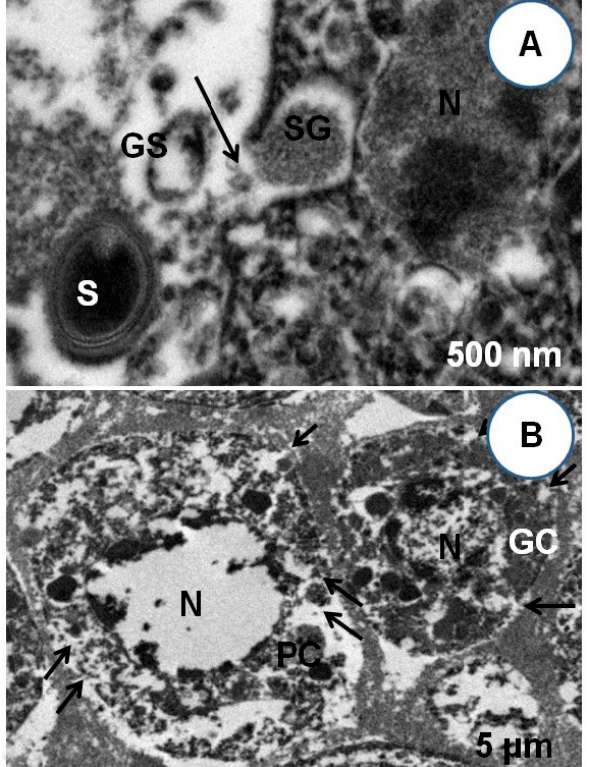
Figure 4. TEM observations on hemocytes of fifth instar larvae of B. mori showing subcellular variations after infection with N. bom- bycis . Hemocytes (A) showed degranulation by exocytosis (arrow) to the microsporidian infection locale; (B) Plasmatocyte (PC) and granulocytes (GC) showed membrane disintegration (arrows) after infection with N. bombycis. S- spore; GS- ghost spore; SG- struc- tured granules; N- nucleus.